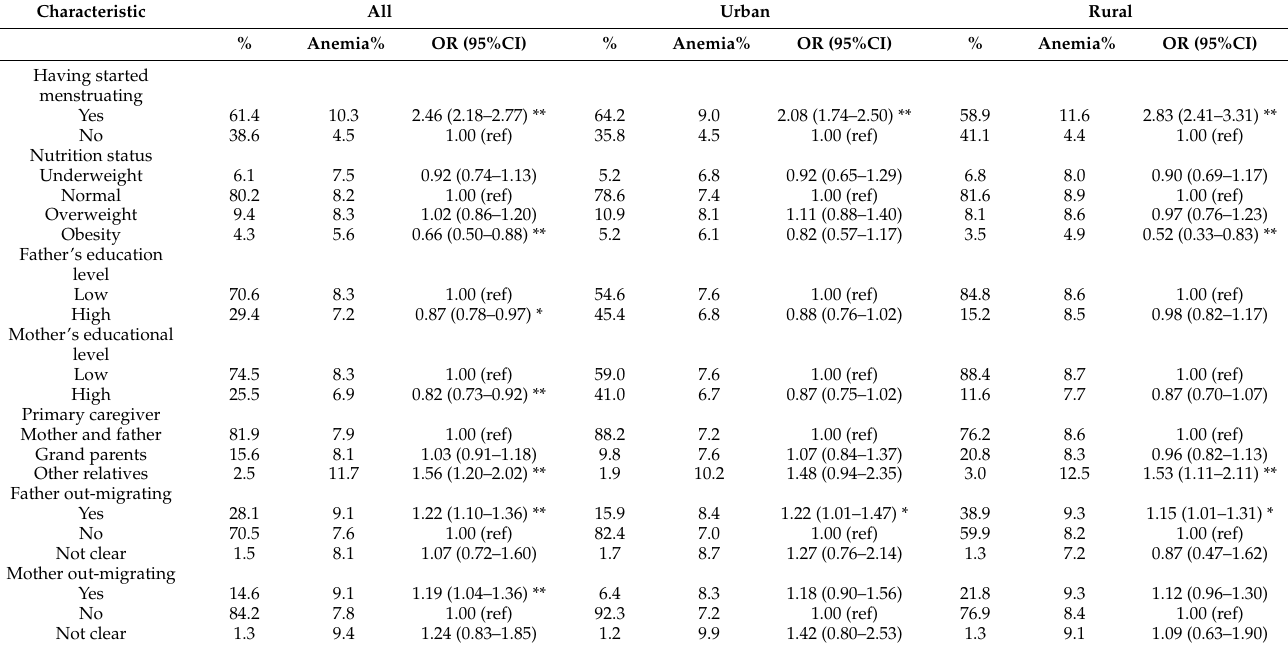
Table A1. Risk factors of adolescent girl anemia from univariate logistic